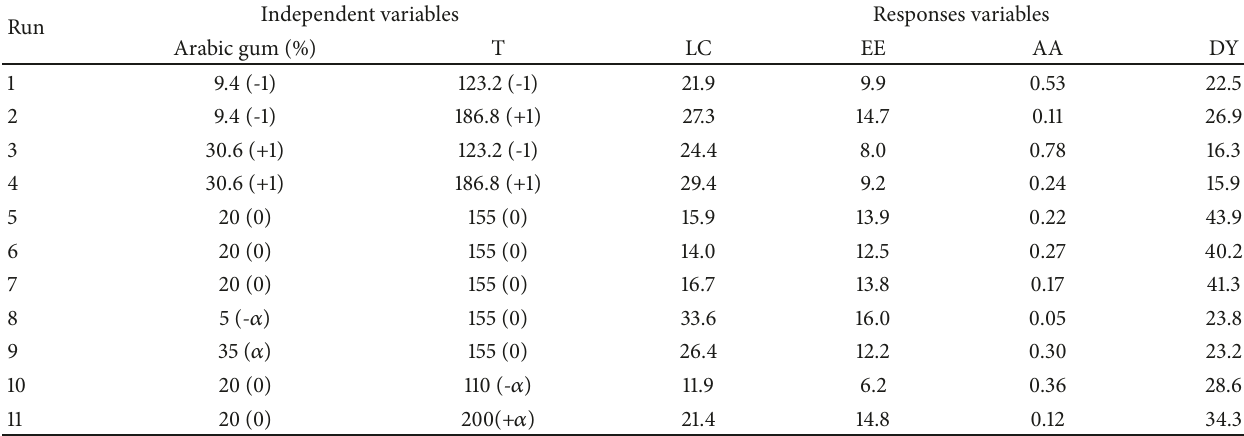
Table 1: Experimental design with coded and decoded values of independent variables and spray drying responses. Independent variables Responses variables Run Arabic gum